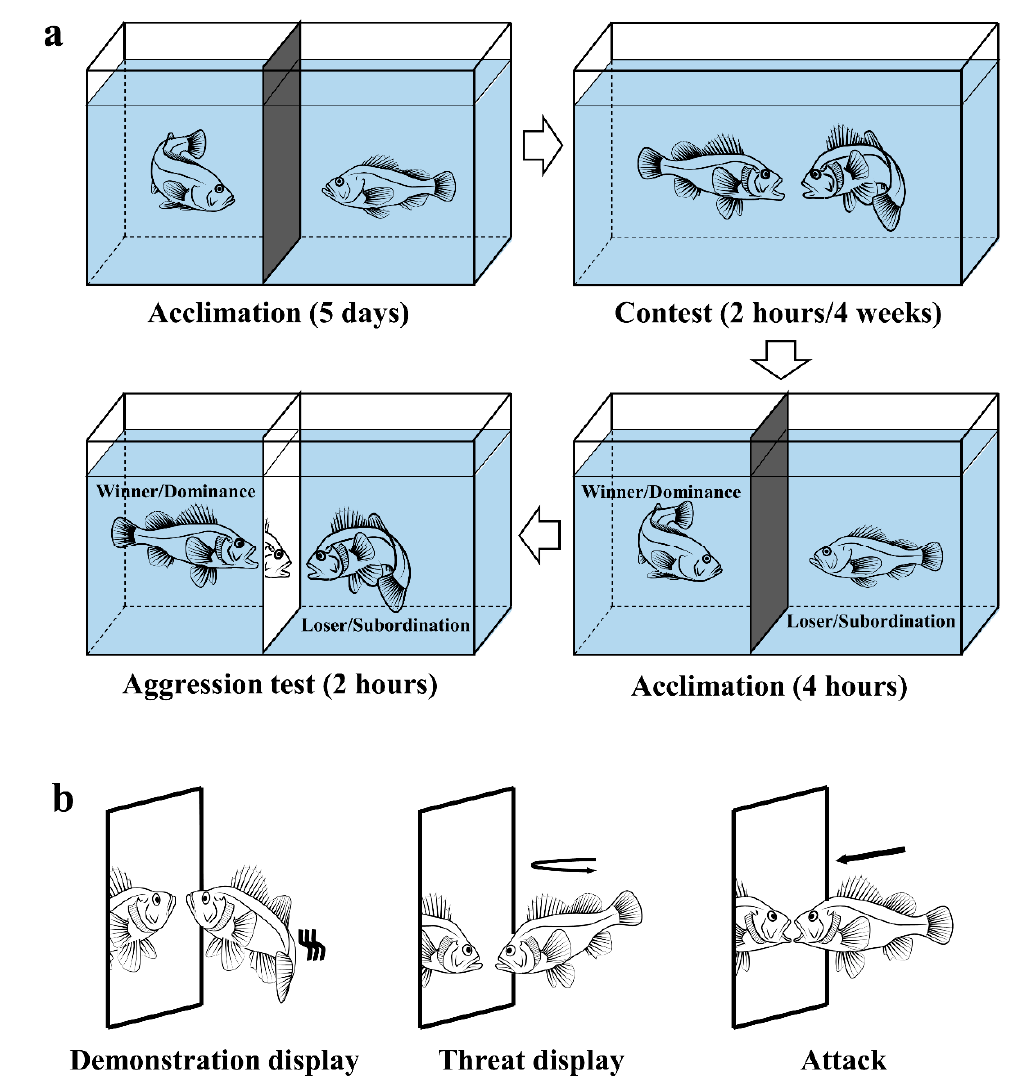
Figure 1. Schematic drawing of ( a ) the experimental tanks and ( b ) the representative aggressive acts of black rockfish in mirror interaction (aggression test).